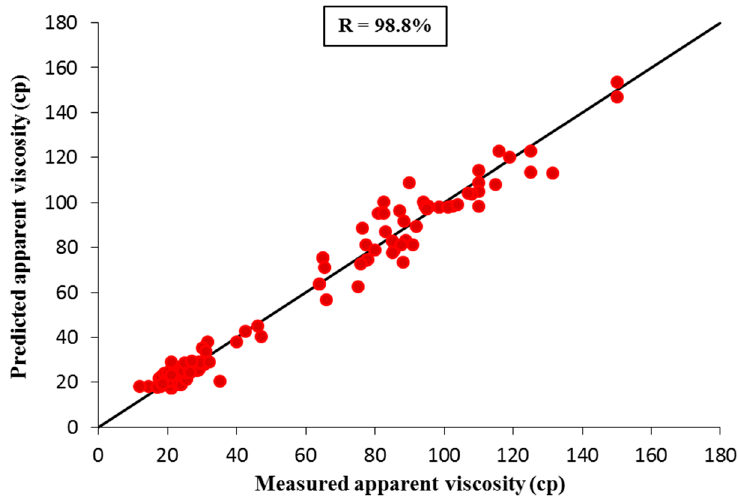
Figure 5. Cross-plot of the measured (experimental) and predicted apparent viscosity from the newly developed correlation.